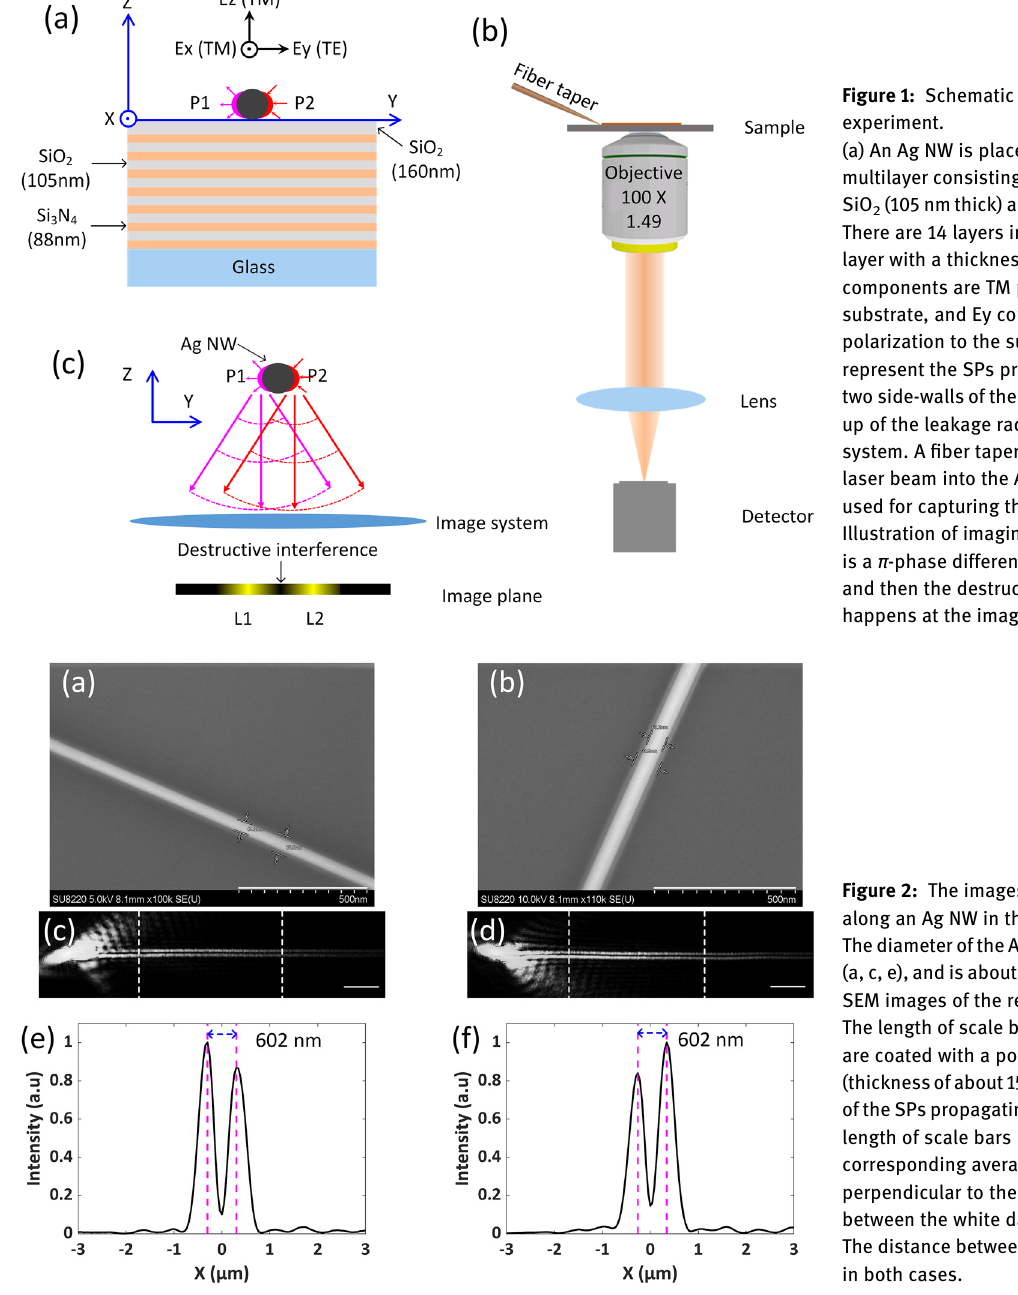
(inset graph on Figure 3(a)) is plotted in Figure 3(a), which shows the distance between the peaks of the two plasmonic fi elds is 90 nm, which is equal to the total diameter of the PVP-coated Ag NW and far below the diffraction limit. During the experiment, the incident wavelength is fi xed at 590 nm and the numerical aperture (NA) of the objective is 1.49. Hence, the diffraction limited spatial separation that can be resolved by the imaging system should be no less than 242 nm (0.61 × 590/1.49 nm). However, our experi- mental results, as shown in Figure 2, demonstrate that two